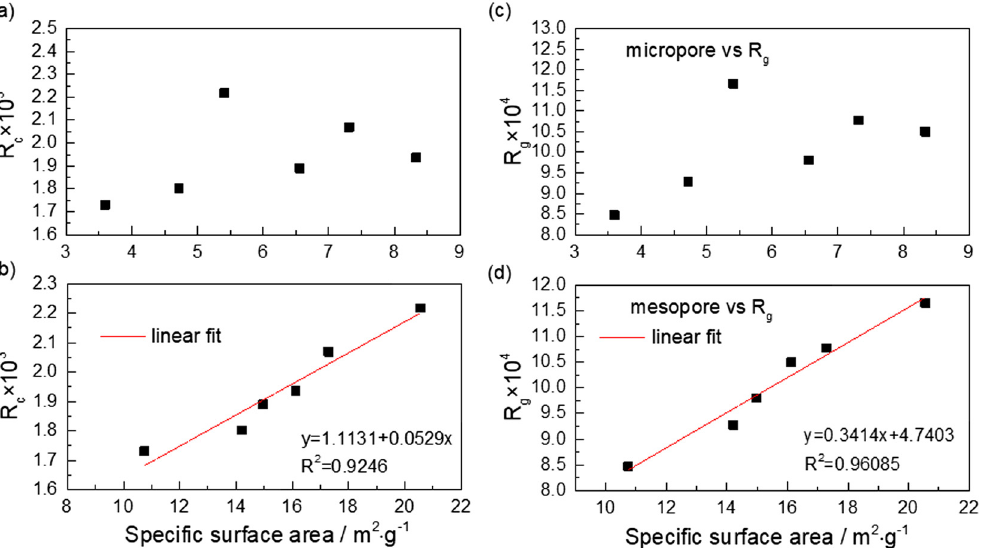
Figure 9: Relationships between semi - coke - speci fi c surface area and reactivity indexes. ( a ) Micropore vs R c ; ( b ) mesopore vs R c ; ( c ) micropore vs R ( d ) mesopore vs R g ; g